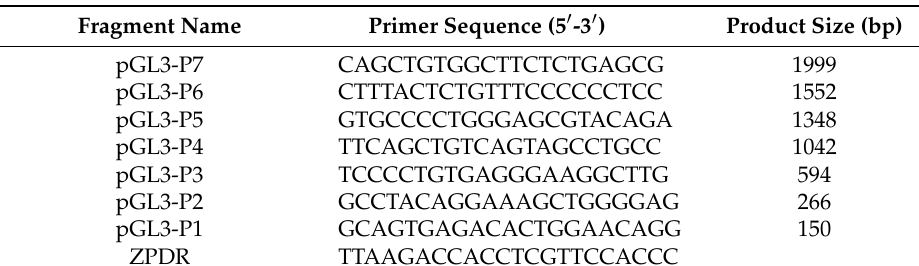
Table 2. Primer sequences of the promoter fragment.